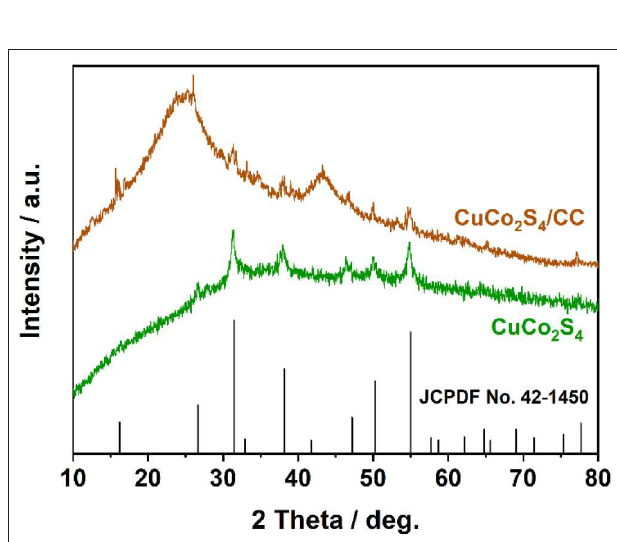
FIGURE 1 | XRD patterns of CuCo 2 S 4 /CC and CuCo 2 S 4